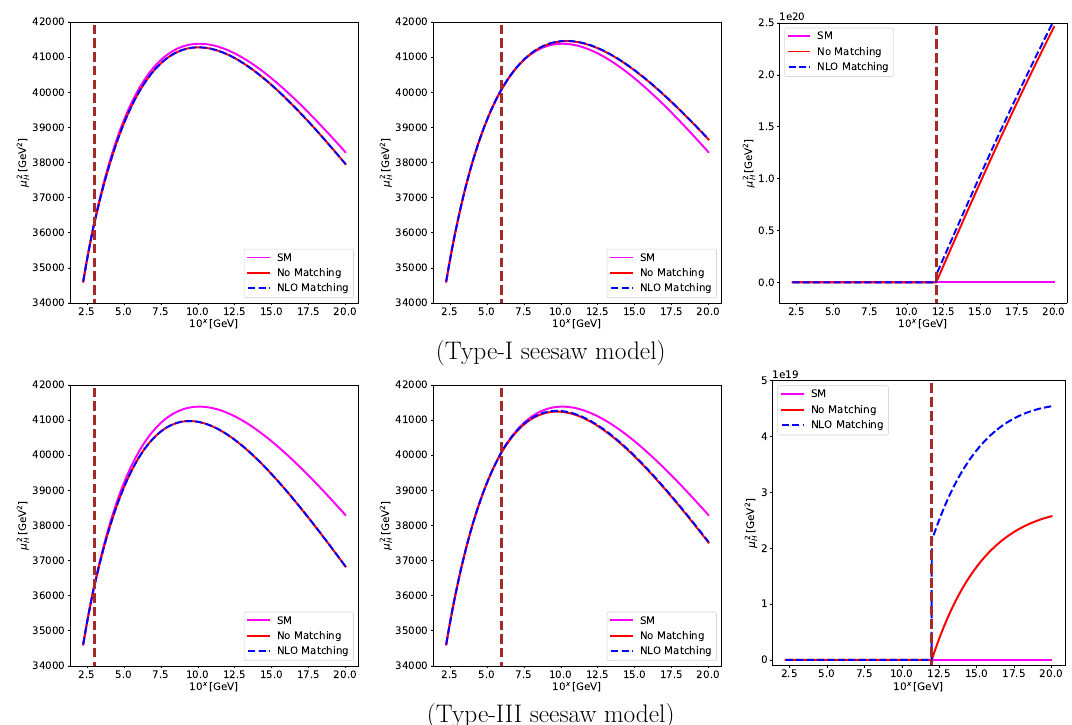
in the type-I (first row) and -III (second row) seesaw models. The first, Figure 5 . Running of µ 2 H second and thirs plots in each row are for BM1, BM2 and BM3 in table 10, respectively. In each plot, we use the vertical dashed line in brown to indicate the matching scale. The magenta curve is obtained from solving the SM RGEs up to the Planck scale. The red (dashed blue) curve is for the running of µ 2 without (with) the inclusion of one-loop H